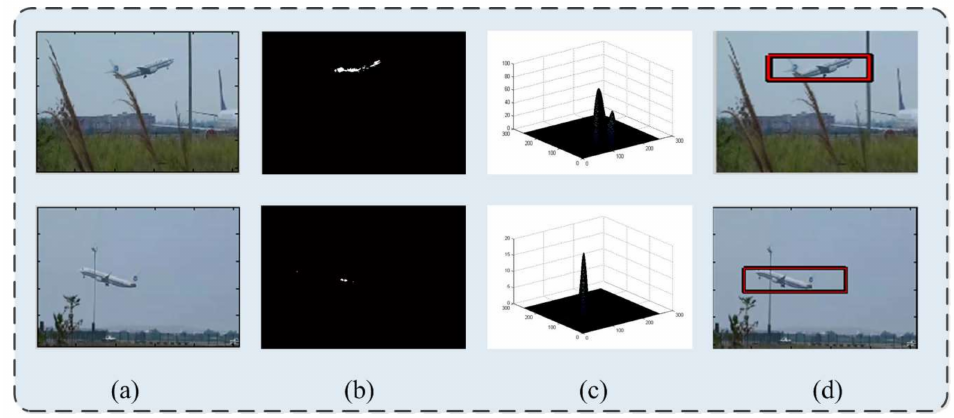
Figure 6. ( a ) Testing image; ( b ) the score map calculated by classifier; ( c ) illustration of the distribution of the regional maxima; and ( d ) detection